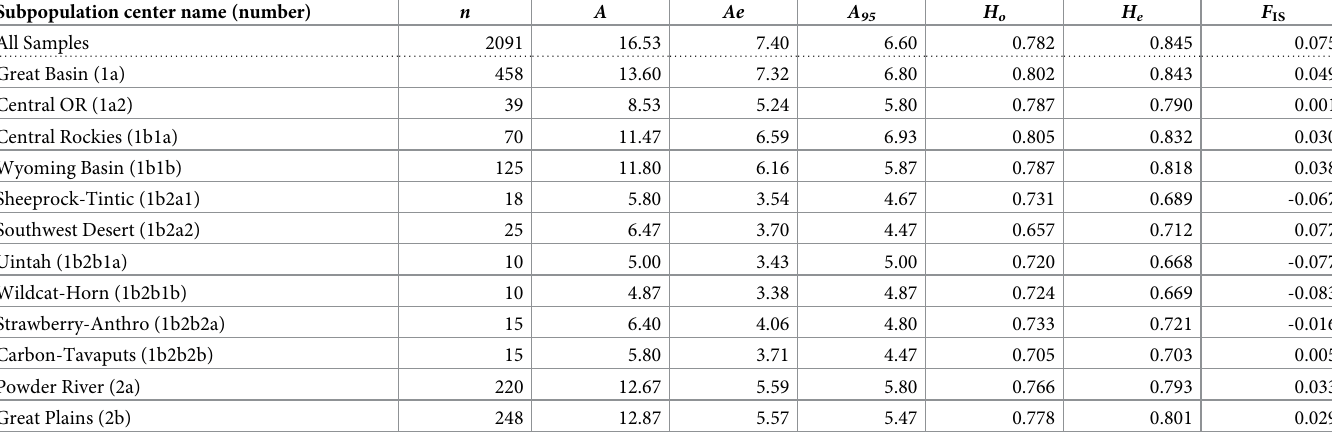
Within the table, n = sample size, A = average number of alleles across 15 loci, Ae = effective number of alleles (the # of equally frequent alleles required to achieve the same H e ), A 95 = number of alleles with at least 5% frequency, H o = observed heterozygosity, H e = expected heterozygosity, F IS = 1-( H o / H e )–a measure of departure from Hardy-Weinberg proportions (HWP) within groups/subpopulations (positive values indicate a deficit of heterozygotes, negative values indicate an excess of